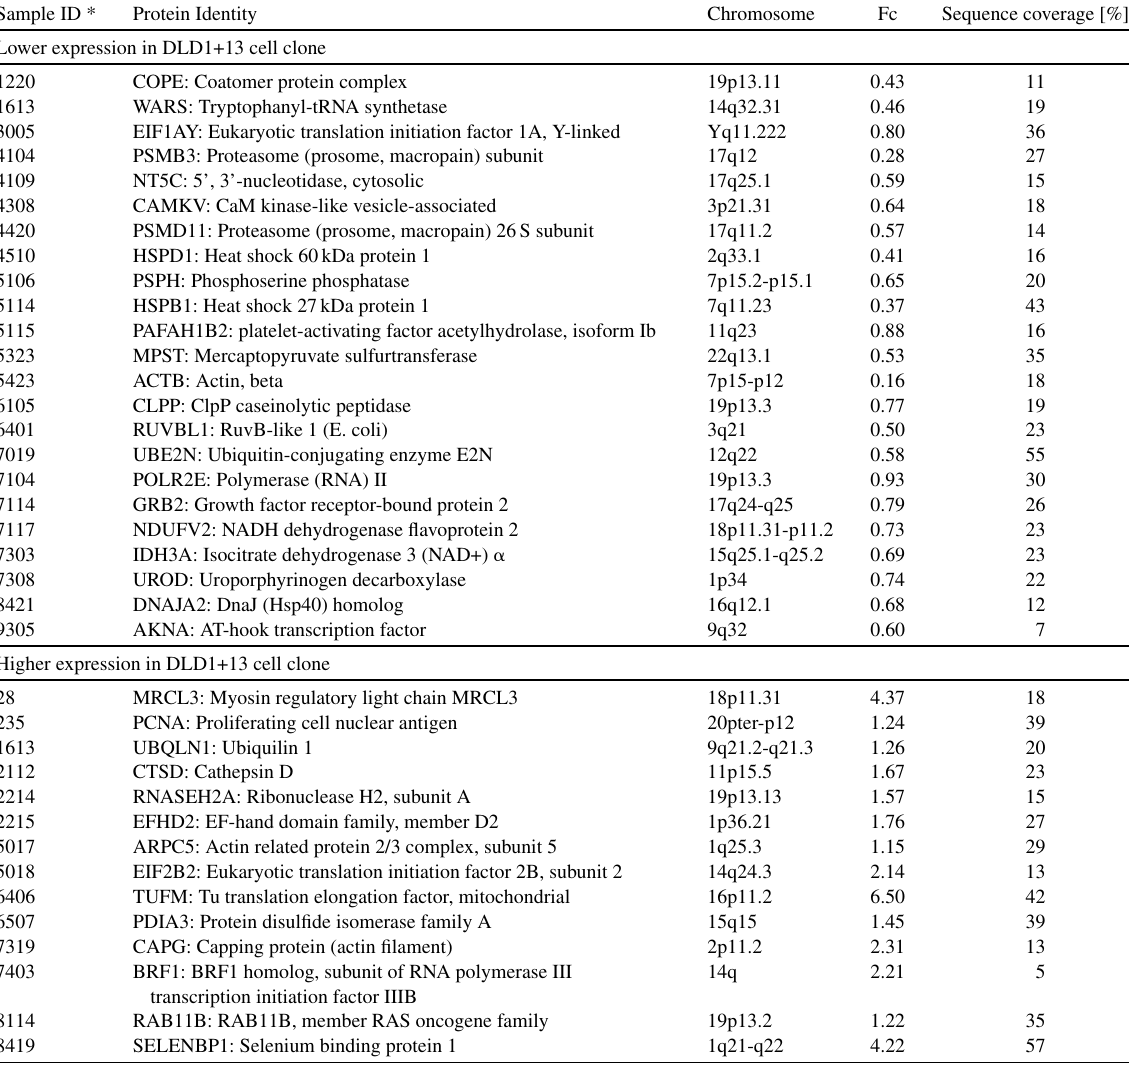
Identifications of the DLD1 versus DLD1+13